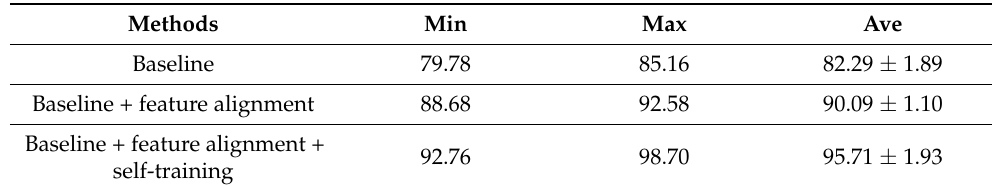
Table 6. Training Scenario II: recognition results in different stages of gradual domain adaptation recognition framework (%).